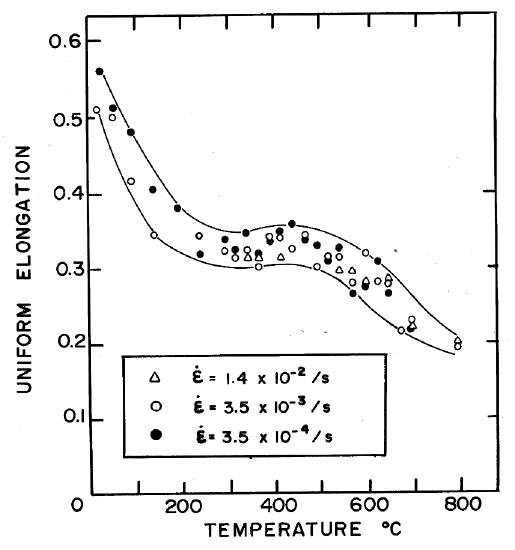
Figure 4. Temperature dependence of the uniform elongation in AISI 304